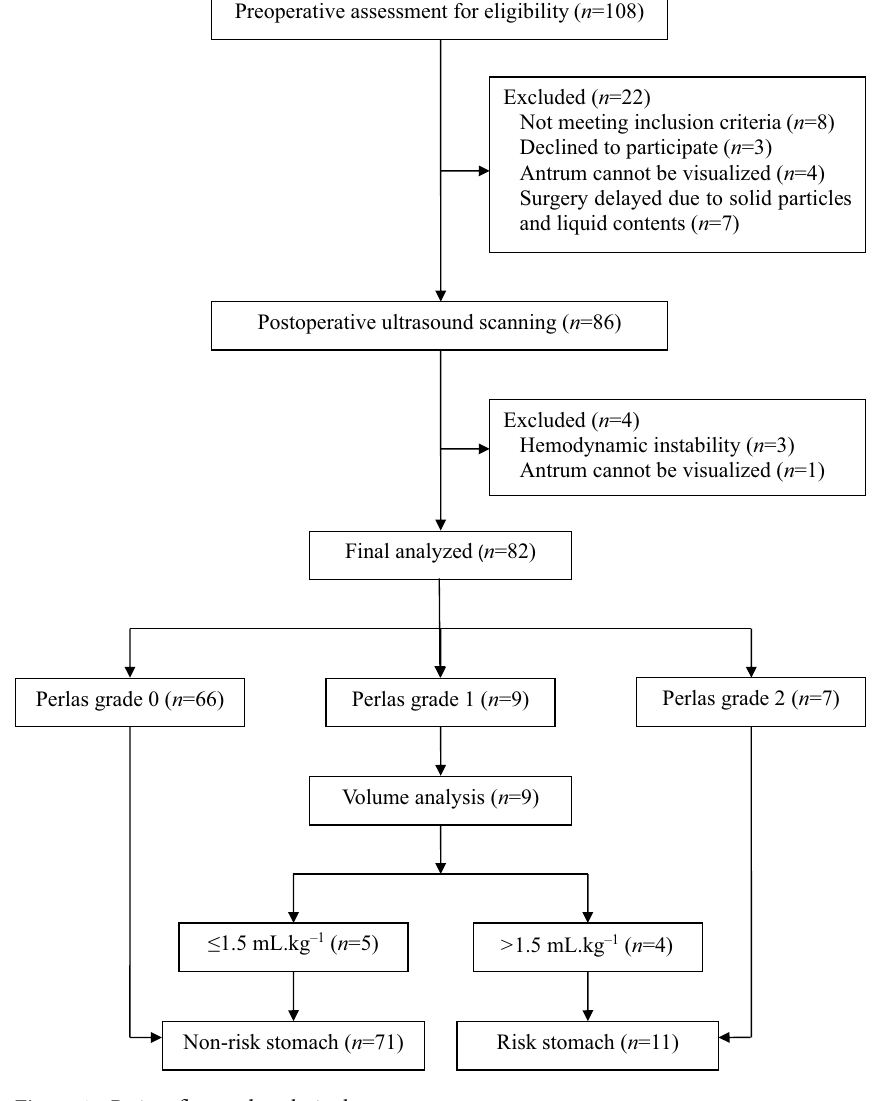
Figure 1. Patient flow and analysis chart.